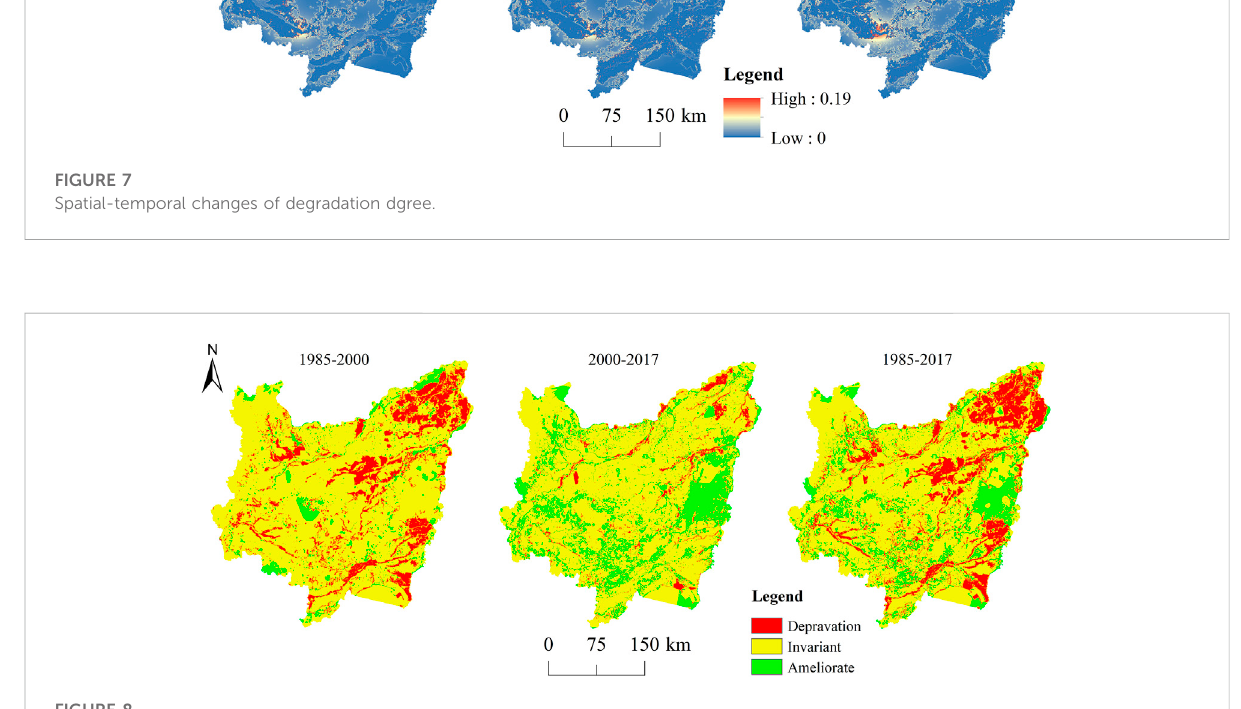
FIGURE 8 Changes in habitat